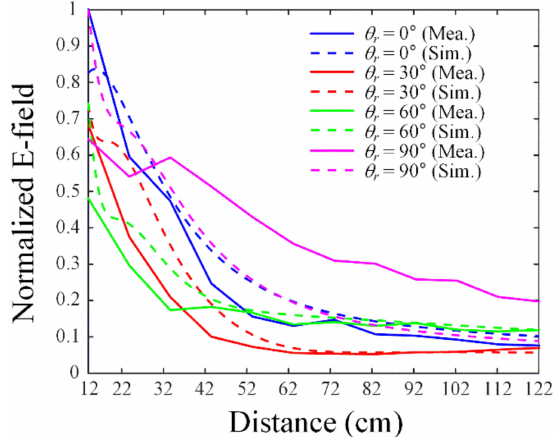
Figure 9. Measured and simulated normalized near-E-field distributions along the z -axis according to the rotation angle.